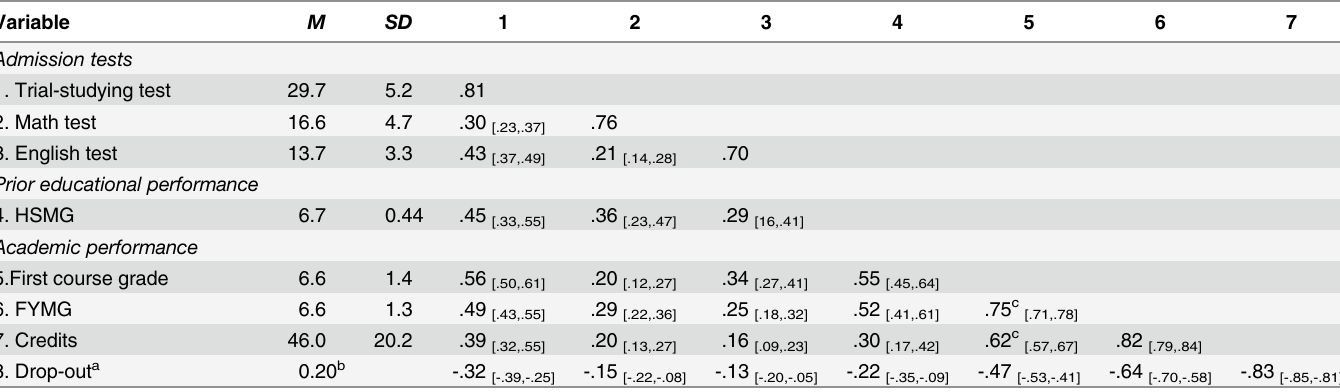
Table 2. Descriptive Statistics and Correlations Between the Predictors and Academic Performance